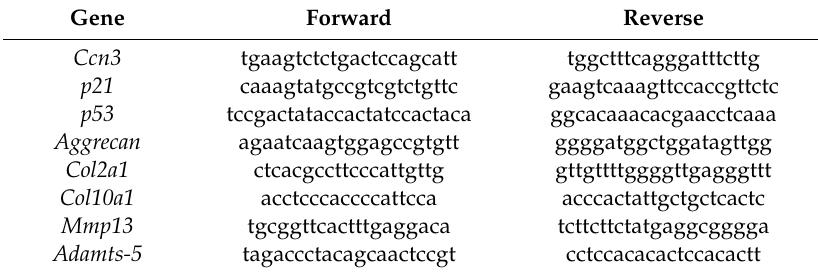
Table 2. Primer sequences for RCS.